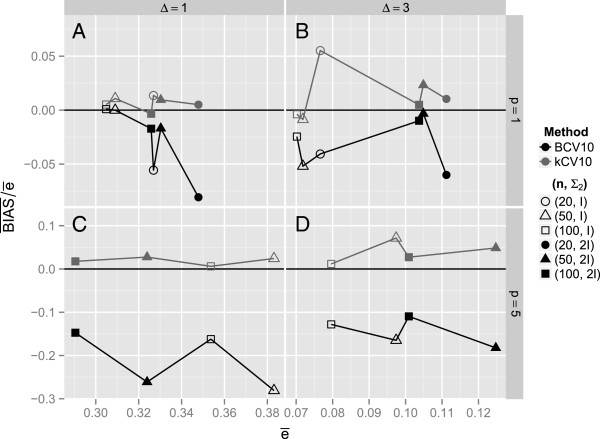
The mean relative bias for each of the twenty simulation configurations in Tables2
and3
and inAdditional file1: Table S1, Additional file2: Table S2, Additional file3: Table S3 and Additional file4: Table S4, where each point is the average of N = 1000 values,BIAS―/e―,like those plotted in Figures1
and2

.